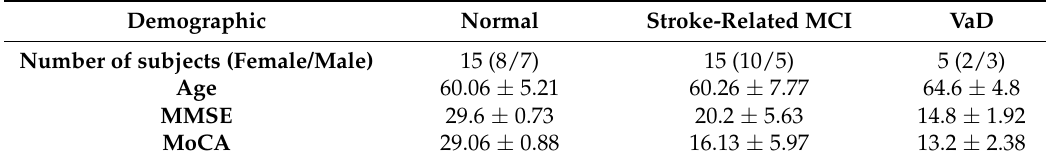
Table 1. Demographic data of the normal subjects, stroke-related MCI and VaD patients. MMSE and MoCA scores are illustrated as well, (Age in years, MMSE and MoCA scores, mean ± standard deviation SD).